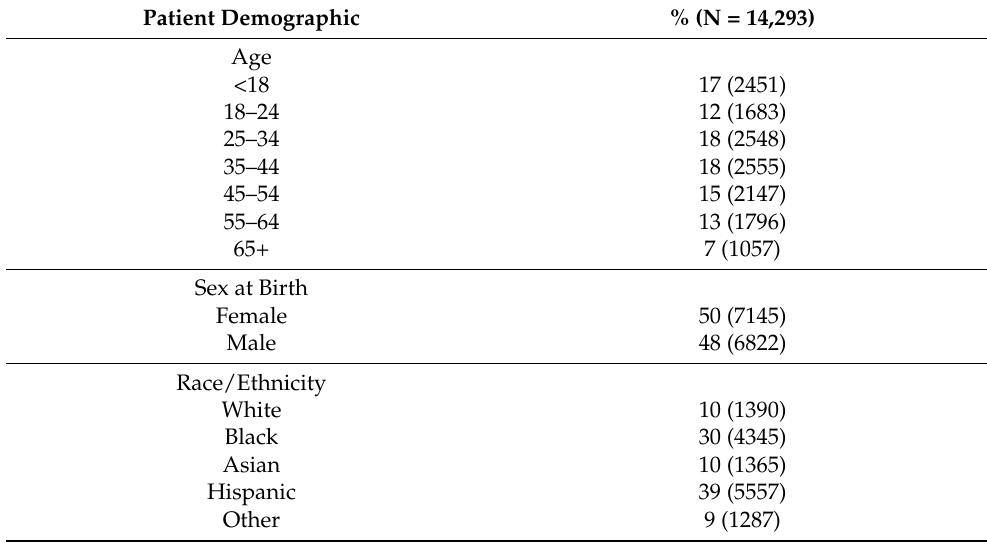
Table 2. Demographics of patients vaccinated through the Program.